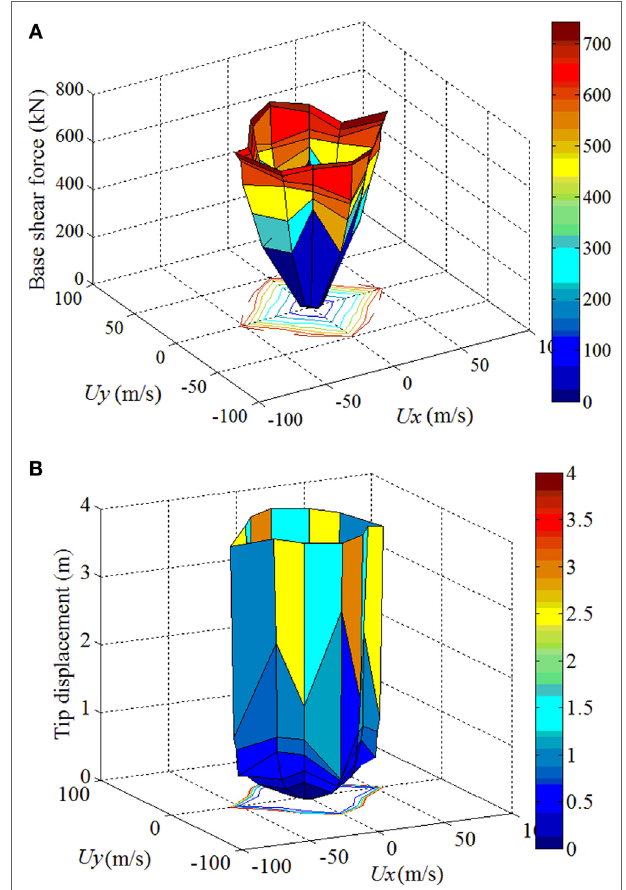
FigUre 11 | Base shear force and top tip displacement . (a) Base shear force. (B) Top tip displacement.